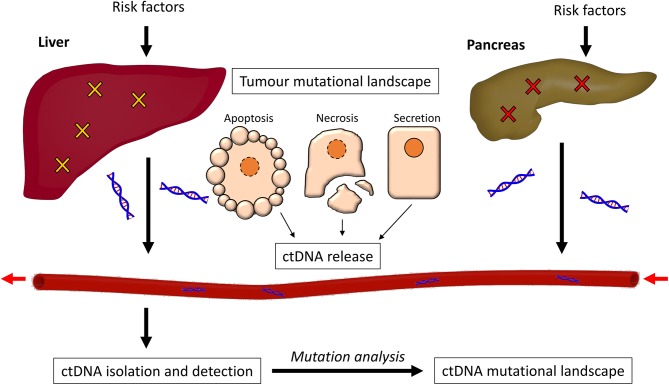
The process of ctDNA generation. Risk factors such as alcohol abuse and exposure to carcinogens promote somatic mutations in both the liver and the pancreas, causing cancer. The cancer cells can release ctDNA in three ways; through apoptosis, necrosis, or secretion. This ctDNA enters the bloodstream and can be isolated through purification methods. The mutational profile of the ctDNA is then detected and analyzed.